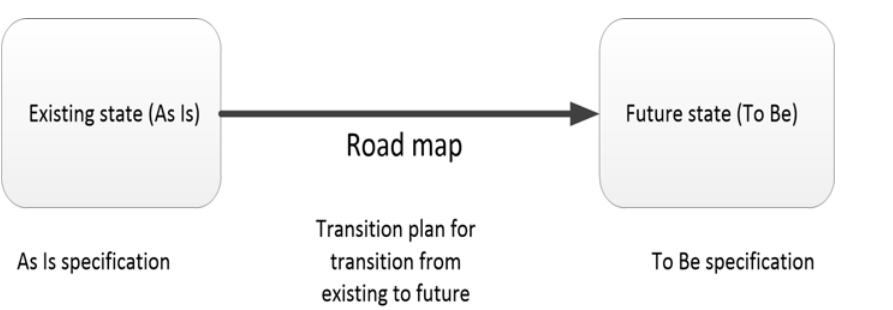
Figure 1 – EA development and transformation process Puc. 1 – Процесс развития и трансформации